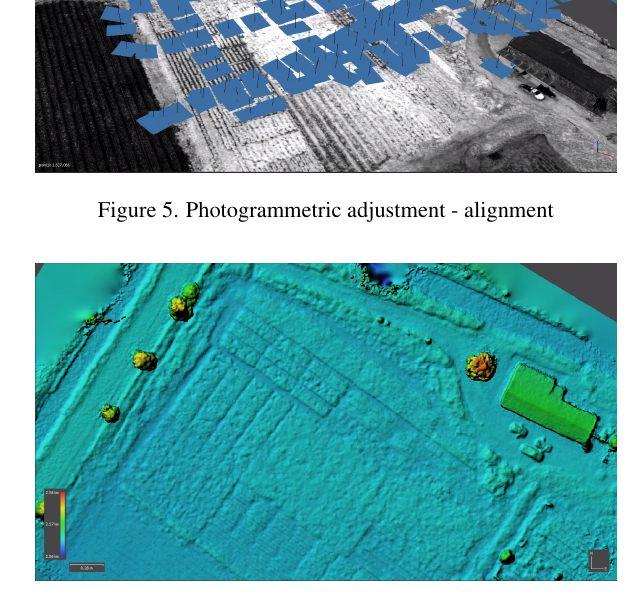
Figure 6. Digital elevation